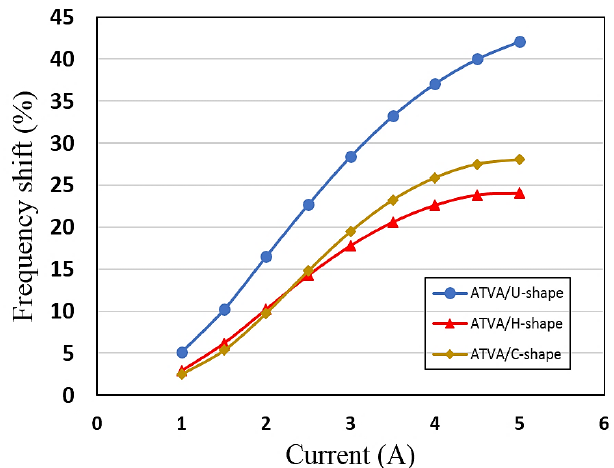
Figure 12. Frequency shift versus input current for the three optimal MRE-ATVAs.